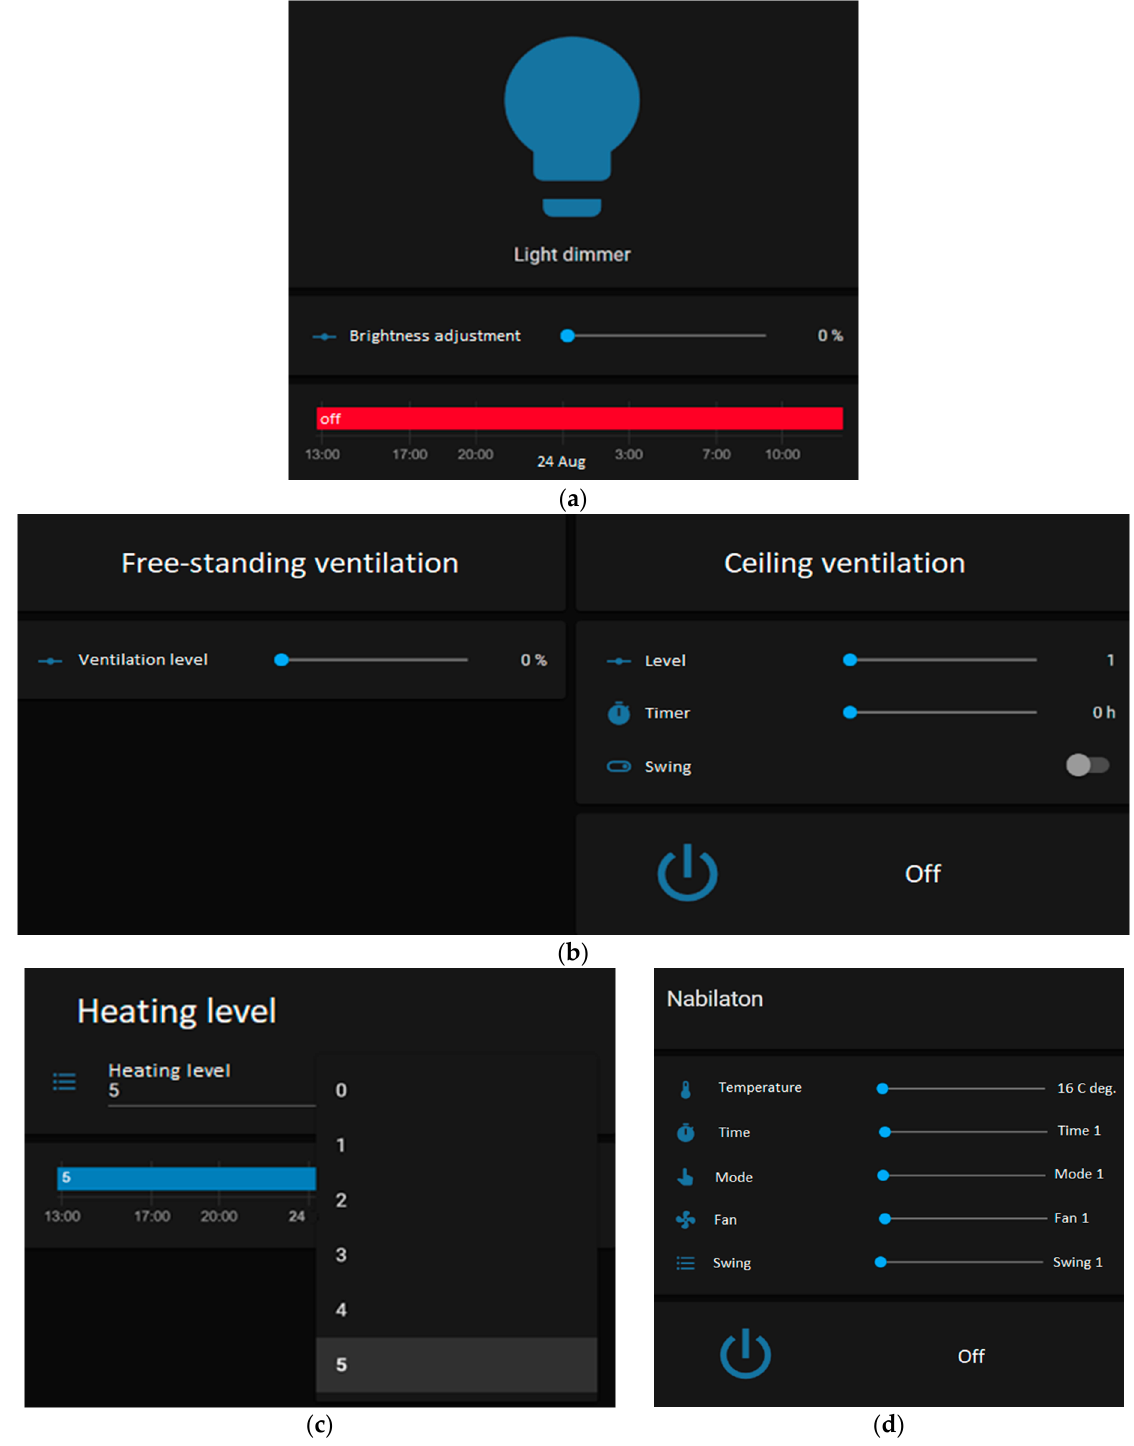
Figure 11. Comfort modules control panels designed by CBRTI Sp. z o.o. Research and Development Center: ( a ) lighting control panel, ( b ) ventilation control panel, ( c ) heating control panel, ( d ) air conditioning control panel.